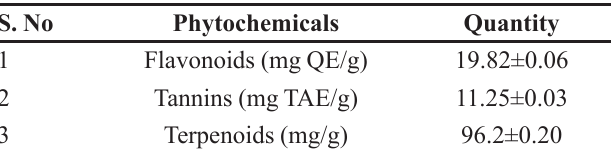
TABLE II - Quantification of Flavonoids, Tannins and Terpenoids S. No